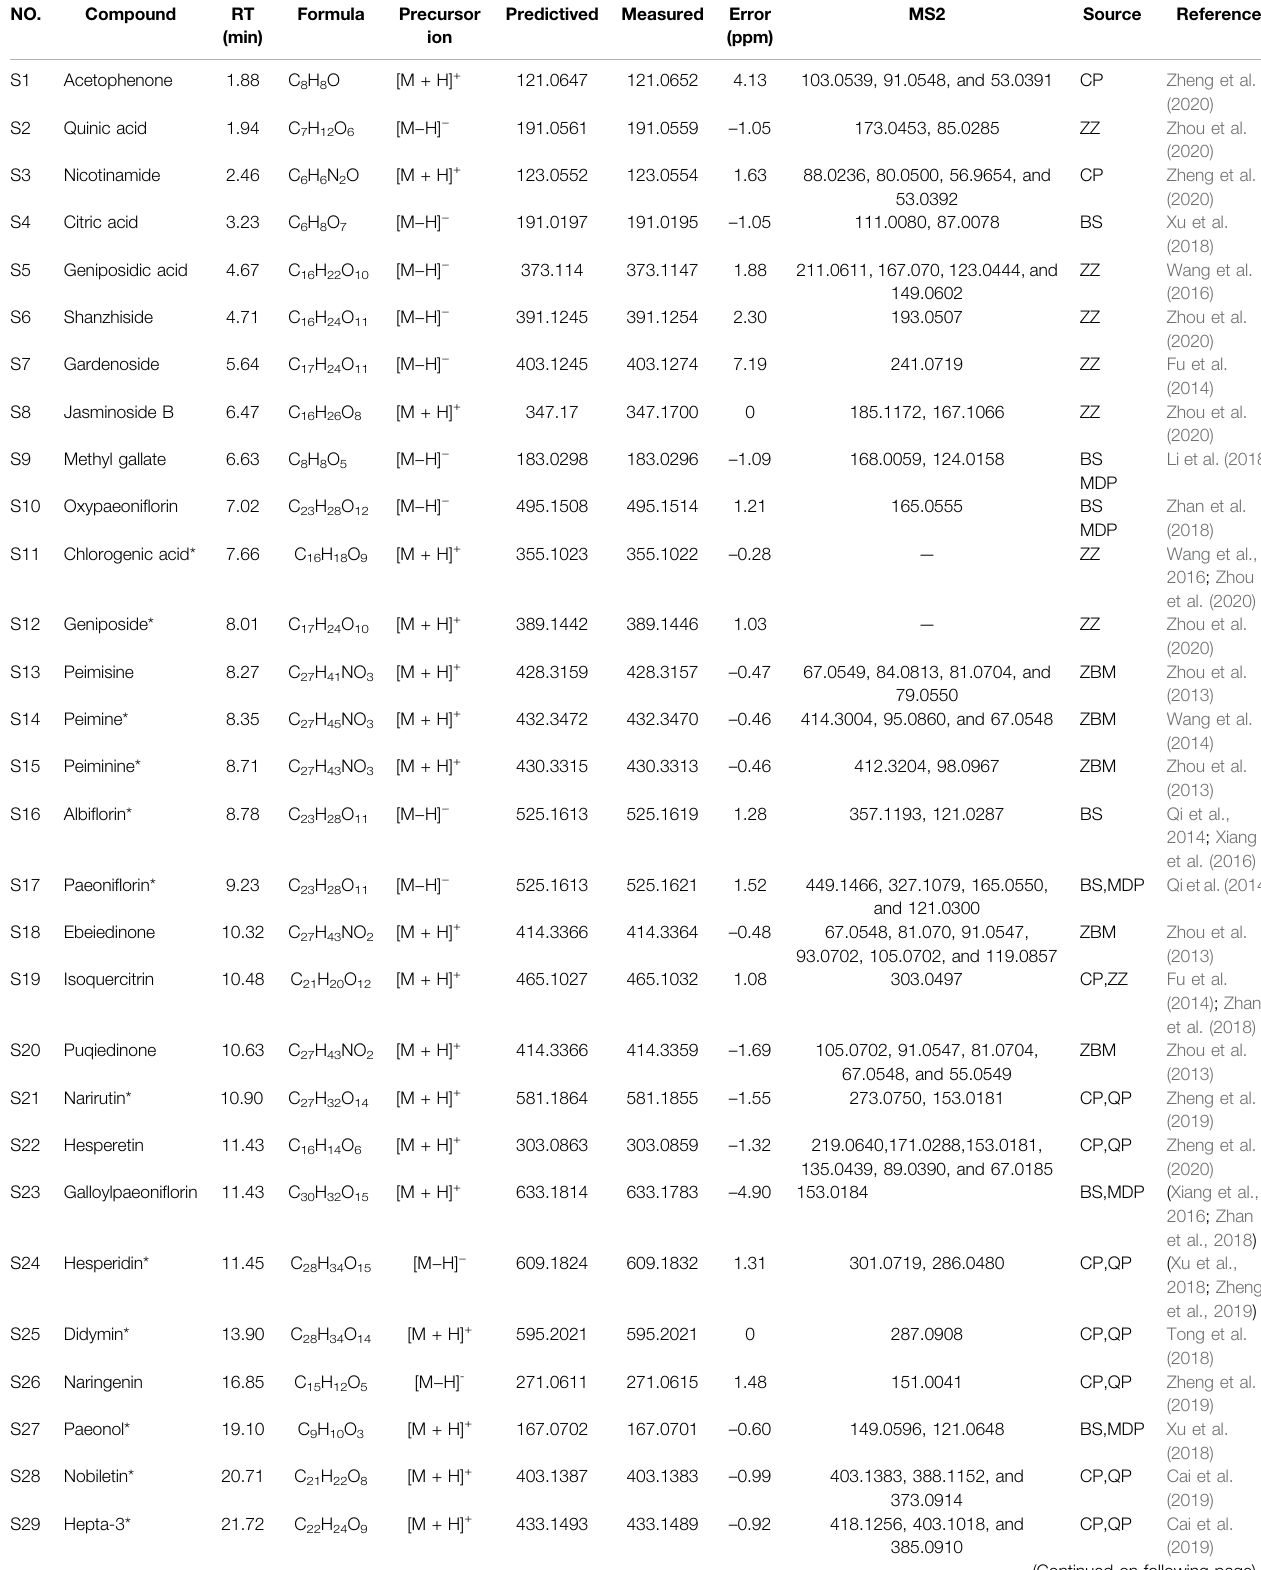
TABLE 1 | Characterization of serum migrant compounds of HGJD by UPLC-Q-Exactive MS/MS.